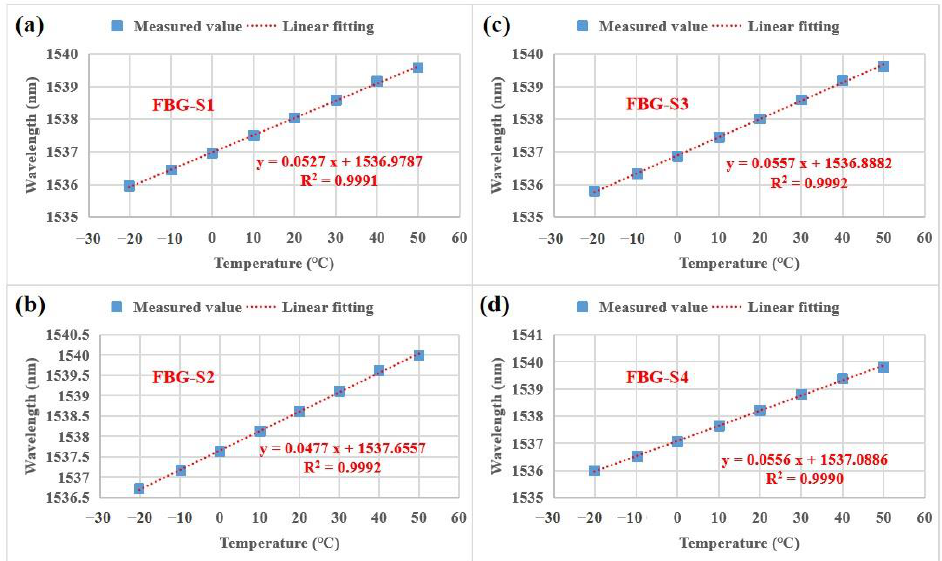
Figure 6. Central wavelengths of the FBG strain sensors as a function of temperature from − 20 °C to 50 °C: ( a ) FBG-S1, ( b ) FBG-S2, ( c ) FBG-S3, ( d ) FBG-S4. The temperatures were program-controlled with a high and low temperature/humidity test chamber. Table 2. Performance comparisons of various FBG sensors reported in the last 20 years (in chrono- logical order).